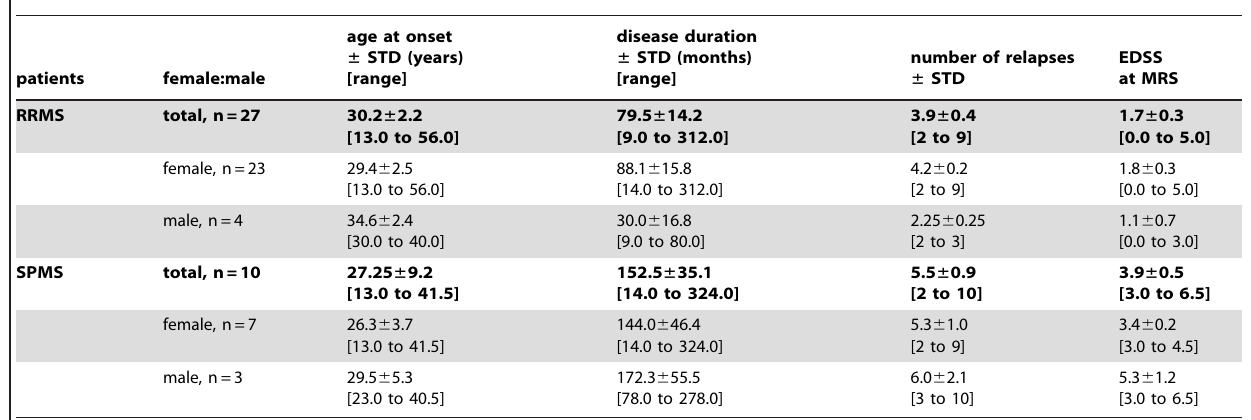
Table 1. Included MS